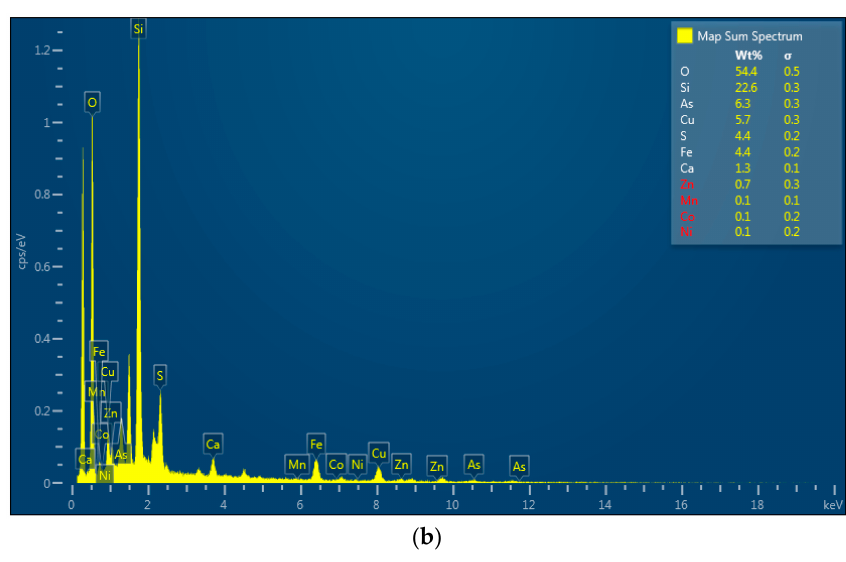
Figure 6. ( a ) Scanning electron micrographs of SRBs and solid phases precipitates inside the sulfate reduction reactors, carbon was used as a surface coating; ( b ) Energy dispersive X-ray spectrum of precipitates solids. Intensity of As, Fe, and S emission lines are shown in the Energy Dispersive X-ray Spectroscopy (EDX) spectrum. Other elements such as Mn, Zn, Ni, Co, Pb, and Al have also been identified. The natural water of the Azufre river has concentrations of these elements, which can also precipitate during sulfate reduction processes. Initial concentrations in batch reactors were As = 3.6 mg·L − 1 , Fe = 81 mg·L − 1 and SO 42 − = 4678 mg·L − 1 (The natural water of Azufre river has others heavy metals identified in the EDX spectrum).